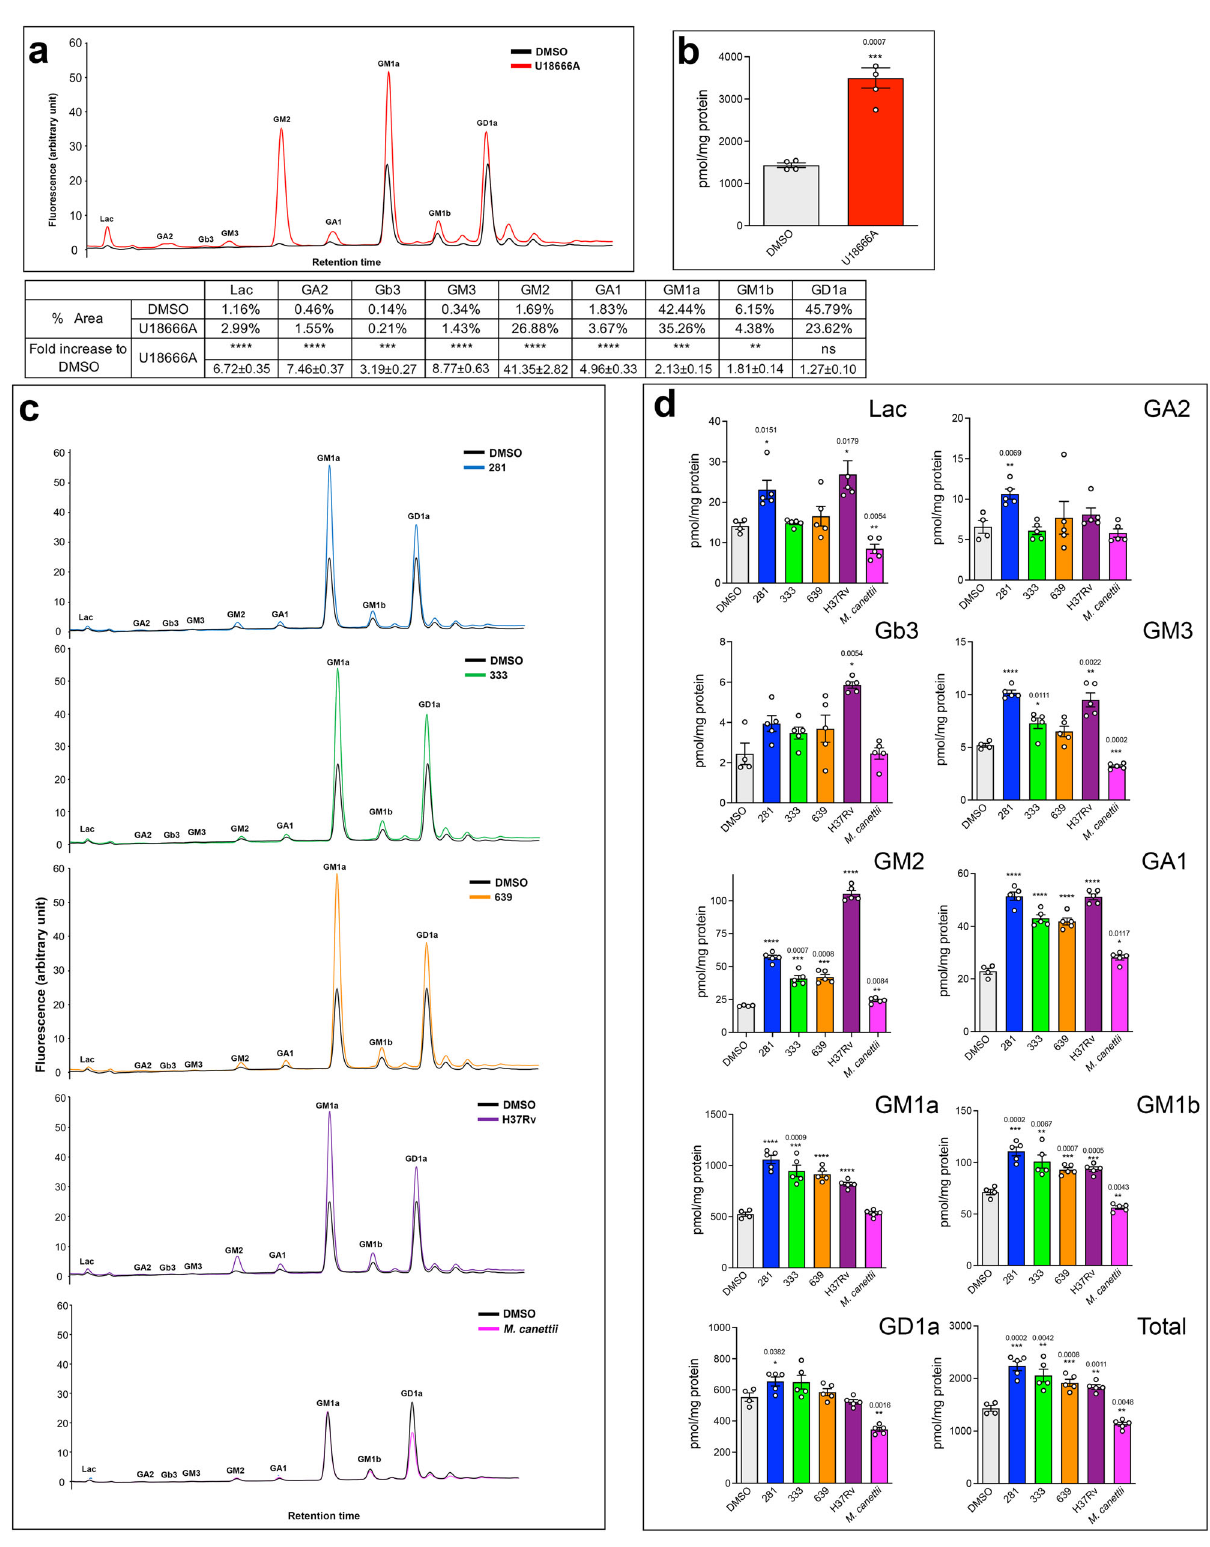
Fig. 7 | Mtb lipids, but not M. canettii lipids cause GSL accumulation in RAW 264.7M Φ . a Representative HPLC trace of GSLs from vehicle (DMSO) and U18666A treated cells are overlaid with individual GSL peaks annotated. The table summarizes the percent area of each peak and the fold increase induced by U18666A. b Quantitation of totalGSLs in DMSOorU18666Atreated cells.Dataare mean±SEM, N = replicates per sample. Statistical analysis, unpaired t test with Welch ’ s correction, two-tailed. *** p <0.0007. c Overlays of representative HPLC